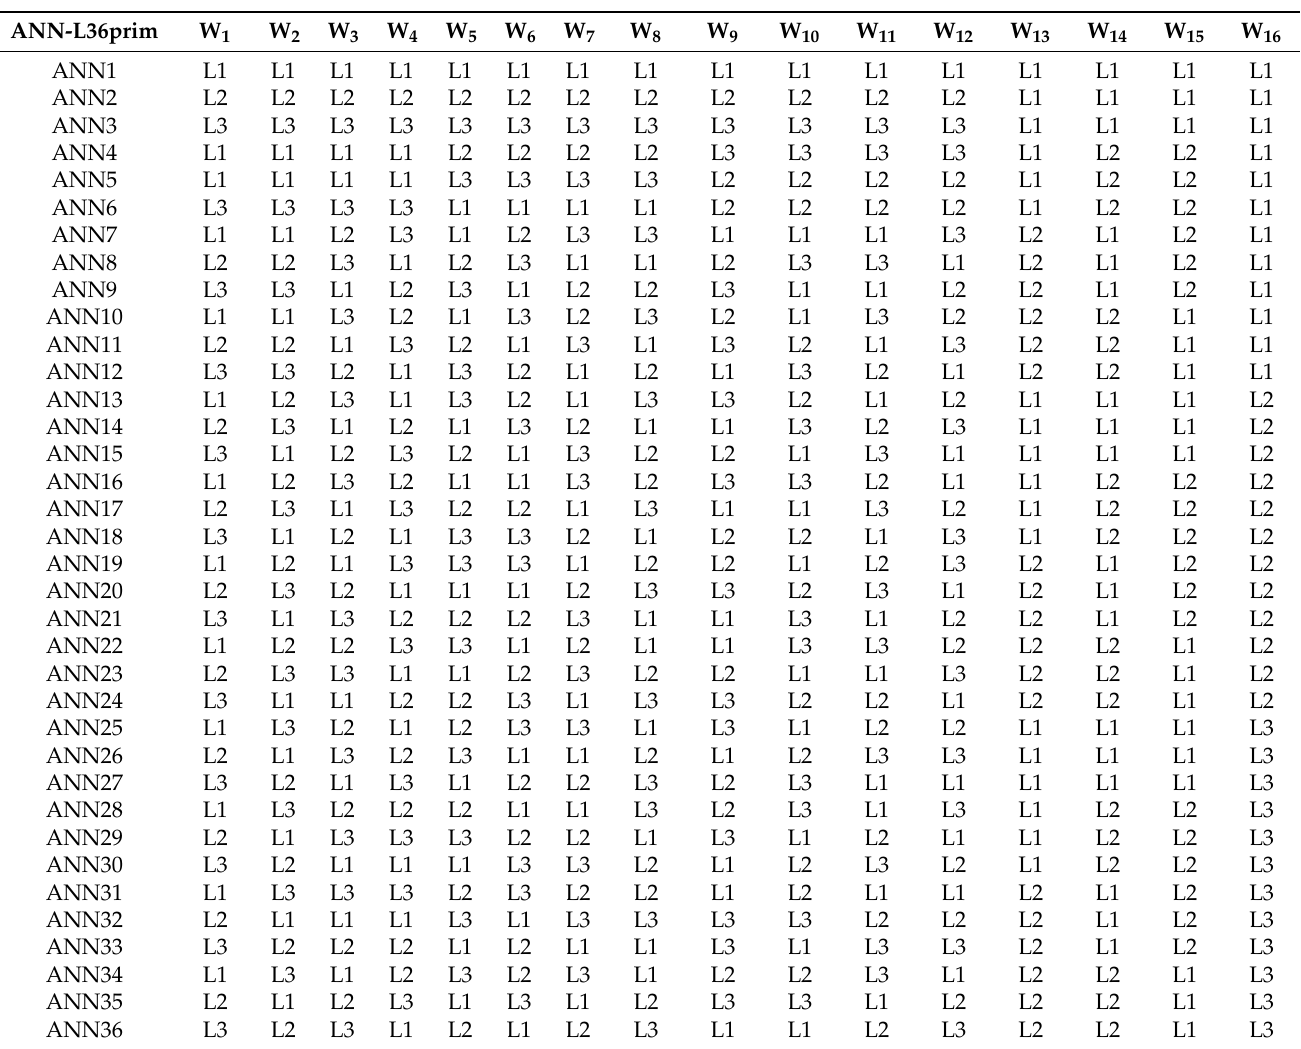
Table 2. Taguchi Orthogonal Array (L36prim = 3 11 2 4 3 1 ).